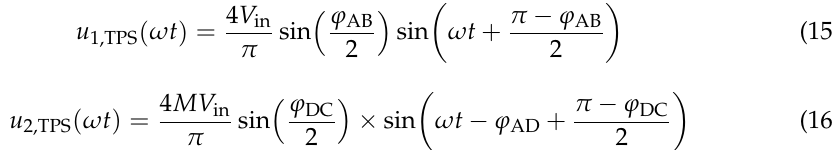
The same power reference values as for EPS modulation are chosen. The expressions for the normalized value of active power P TPS,pu and reactive power Q TPS,pu under TPS modulation are derived as follows (17) and